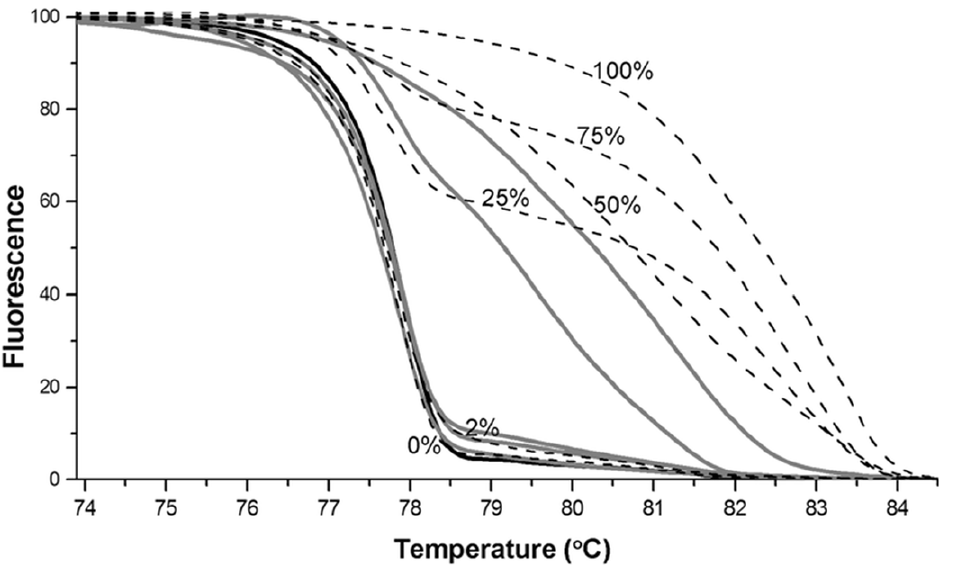
Figure 5. The normalized melting curves of the HRM analyses. Dashed lines represent the standard dilution series from artificially methylated DNA (0%, 25%, 50%, 75% and 100%). The solid black line represents results obtained from a normal sample. Solid grey lines represent results obtained from 5 independent tumorous tissue samples. The HRM analysis can distinguish methylation of the normal and tumorous tissues based on the different G:C contents in the bisulfite-converted promoter sequence. Promoter regions containing more methylated cytosines, which cannot be converted to uracil by the bisulfite treatment, has higher melting temperatures. The melting temperature is proportional to the ratio of non- converted cytosines.